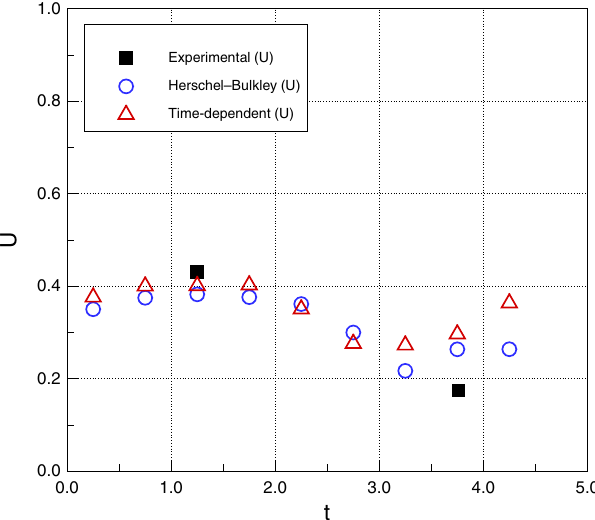
Figure 17. Subaqueous debris case 1: height of head flow ( H , m) and water depth ( D , m) as a function of simulation time ( t , s).